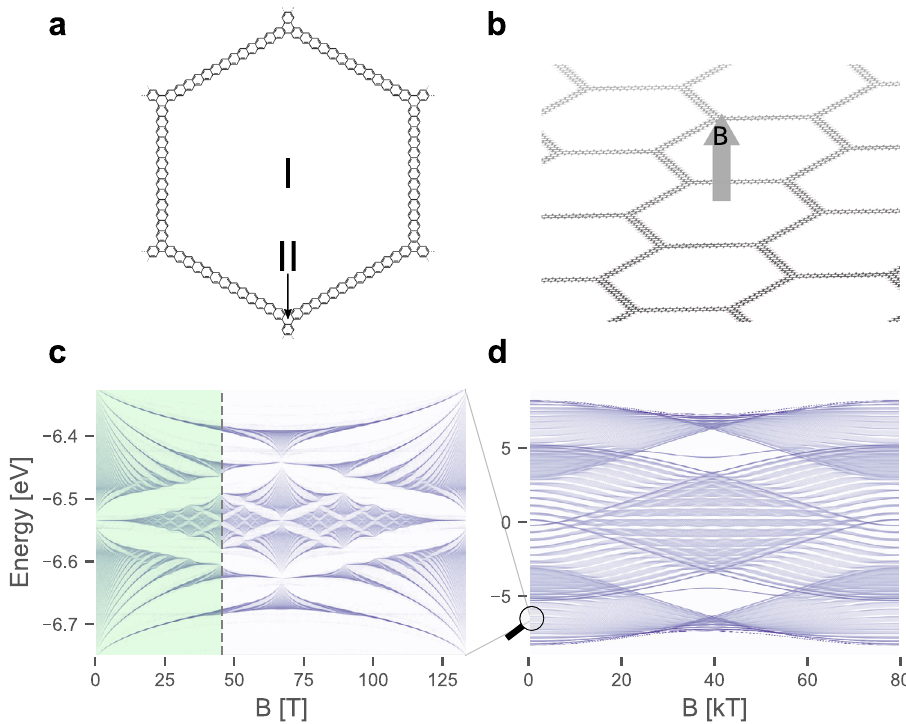
Fig. 4 Towards a measurable HB in 2D COFs with the Starphene-COF. a Structure of the Starphene-COF. b Extended 2D structure of the honeycomb lattice of the Starphene-COF including an indicated applied magnetic fi eld. c HB from 0 to 134 T. The green overlay indicates the range in which the spectrum would be measurable according to the highest achievable magnetic fi eld of 45.5 T 44 . d Butter fl y spectrum from 0 to 80 kT. The intensity of the DOS is depicted in a logarithmic scale although the colorbar was omitted for